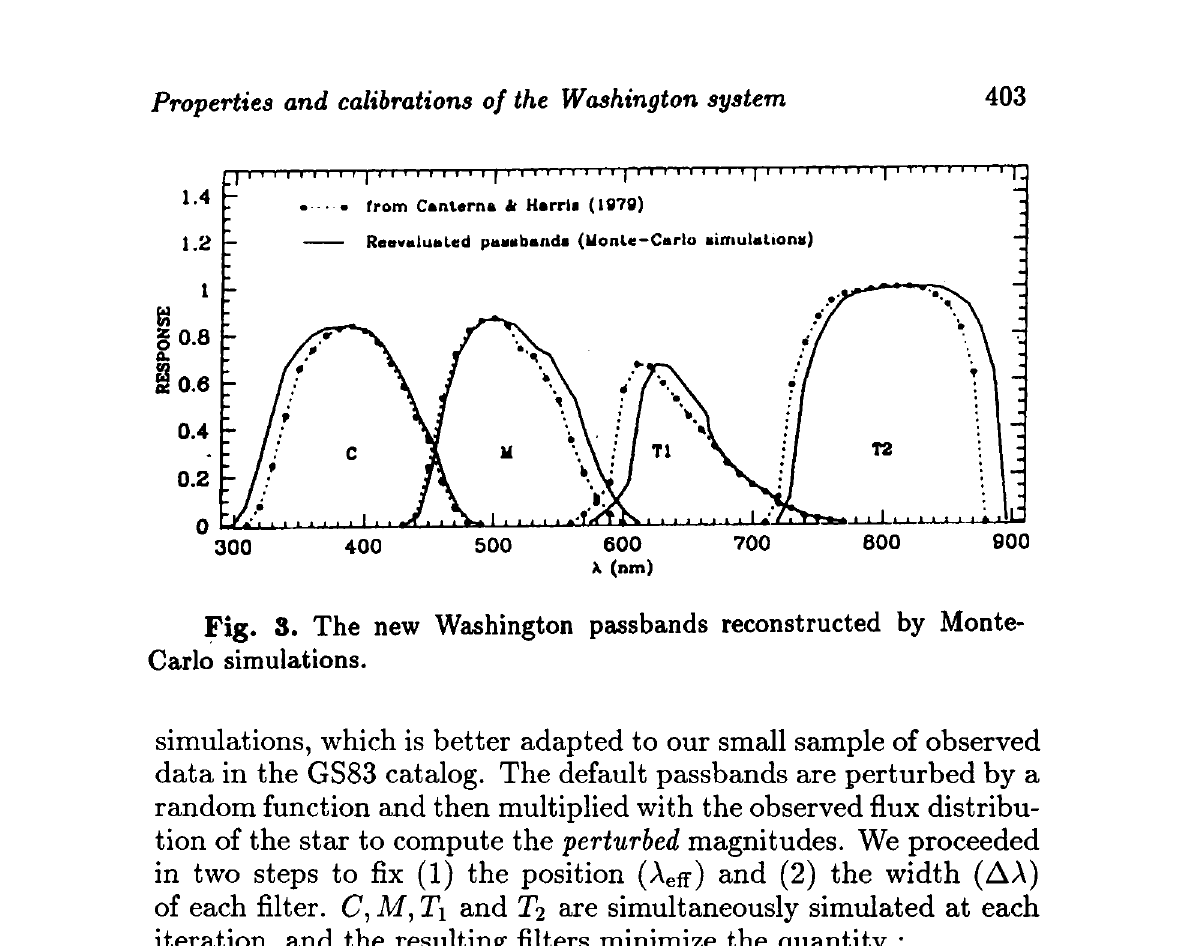
Fig. 3. The new Washington passbands reconstructed by Monte- Carlo